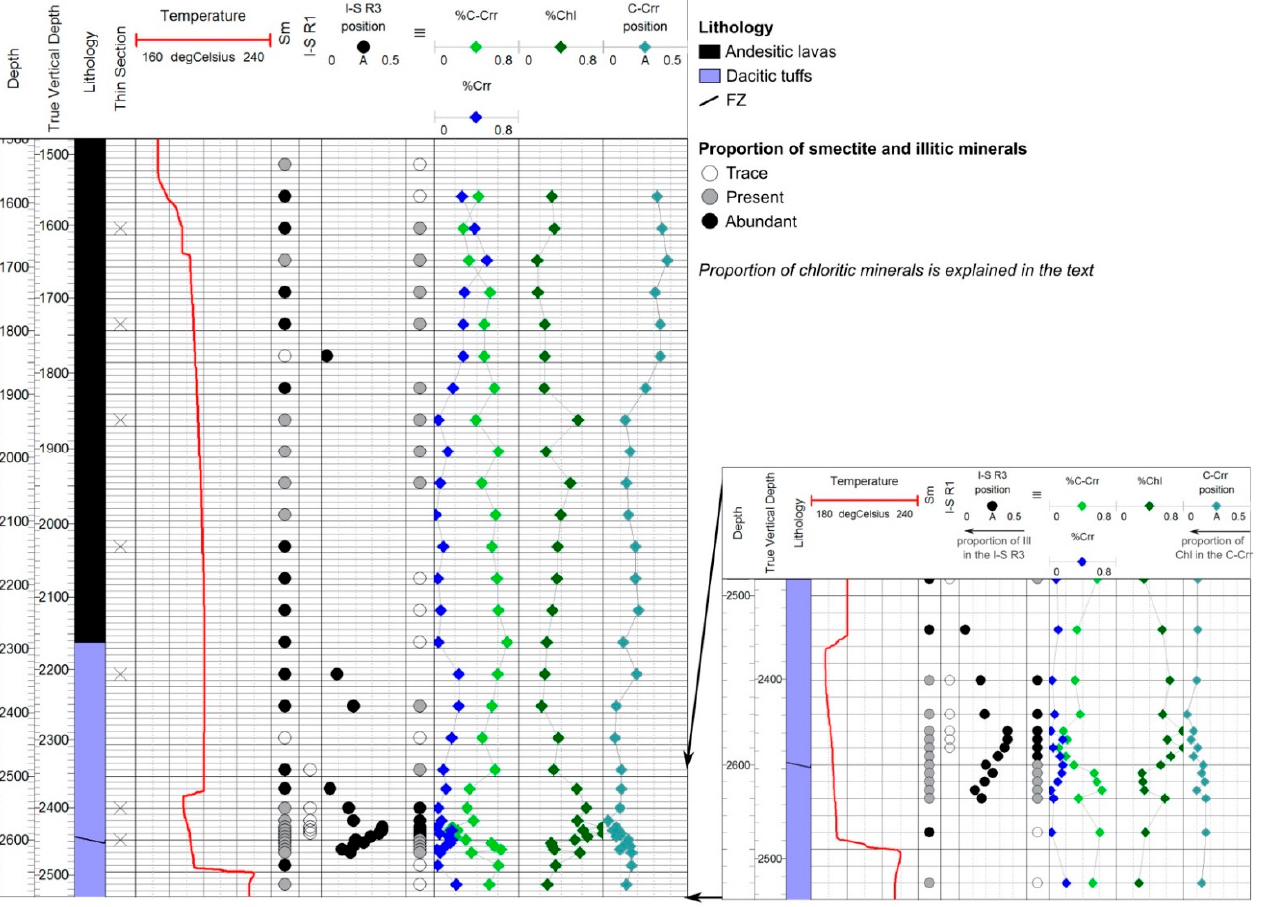
Figure 5. Relative proportion of clay mineral with depth estimated from EG-saturated XRD patterns within the CP-4A well with a close-up of the FZ shown on the right. The temperature profile was measured 2 ½ months after drilling operations. Depth is expressed in m (measured depth). I-S R3 and C-Crr positions are expressed in Ångstrom. Sm: smectite, I-S: illite/smectite mixed layers, Ill: illite, C-Crr: chlorite/corrensite mixed layers, Crr: corrensite, Chl: chlorite.